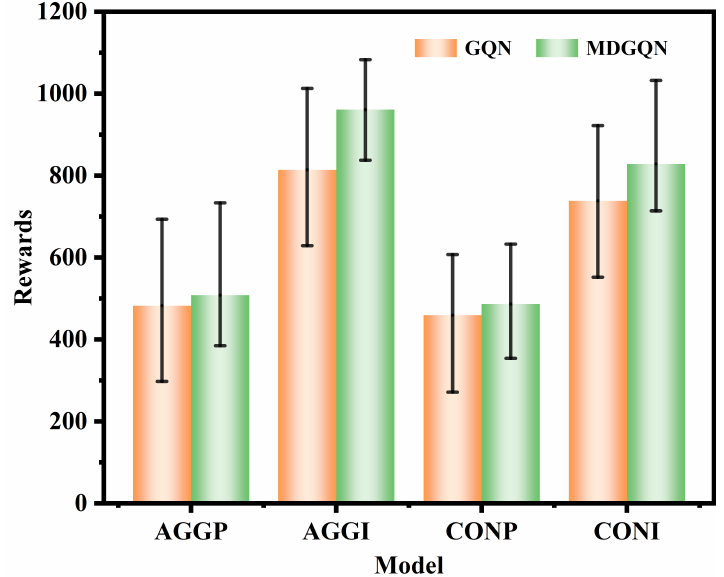
Figure 6. Test reward diagram of four decision-making modes. Orange represents the decision- making mode using the GQN algorithm, and green indicates the decision-making mode using the MDGQN algorithm. In the figure, the two ends of the error rod represent the maximum and minimum values of the test